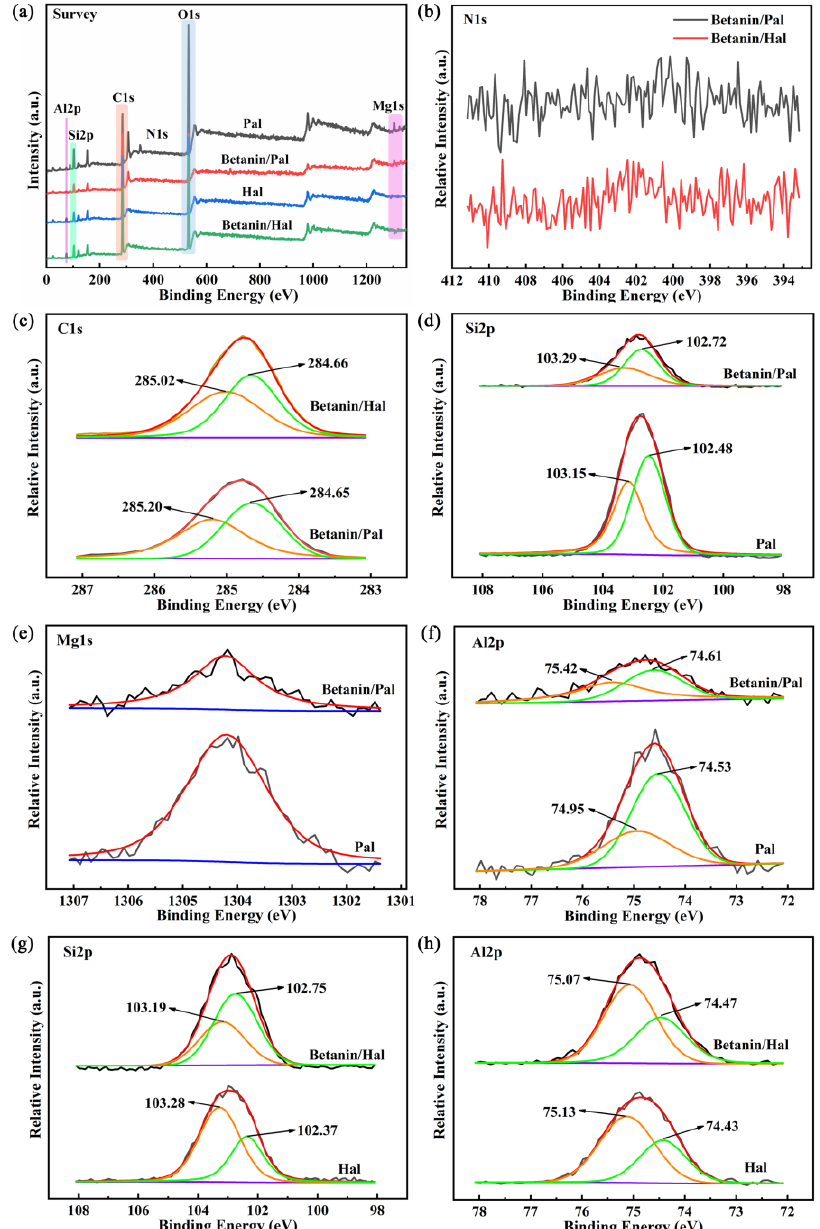
Figure 4. X-ray photoelectron spectra of Pal, betanin/Pal, Hal, betanin/Hal ( a ) high-resolution scanning spectra of ( b ) N1s, ( c ) C1s, ( d ) and ( e ) Si2p, ( f ) and ( g ) Al2p, ( h ) Mg1s.